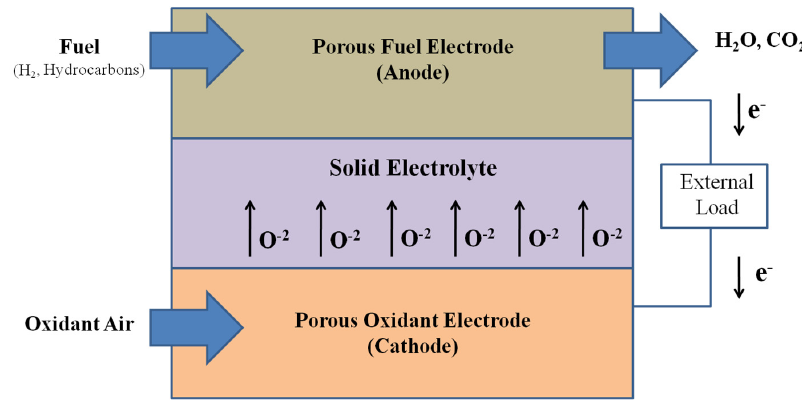
Figure 1. Schematic of solid oxide fuel cell.